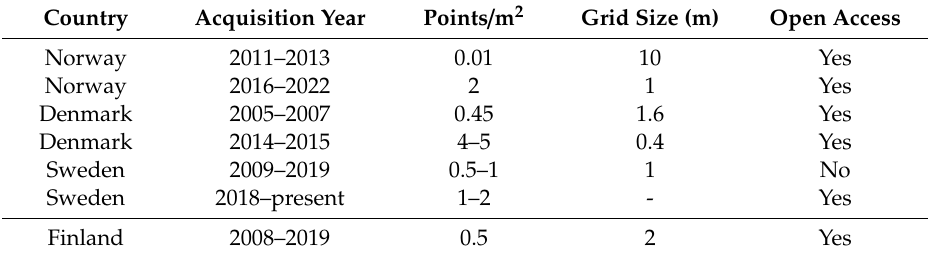
Table 1. Overview of national airborne laser scanning (ALS) coverage in Norway, Denmark, Sweden, andFinland. Thetablealsoshowswhenthedatawereacquiredaswellastheirresolutionandavailability. Country Acquisition Year Points / m 2 Grid Size